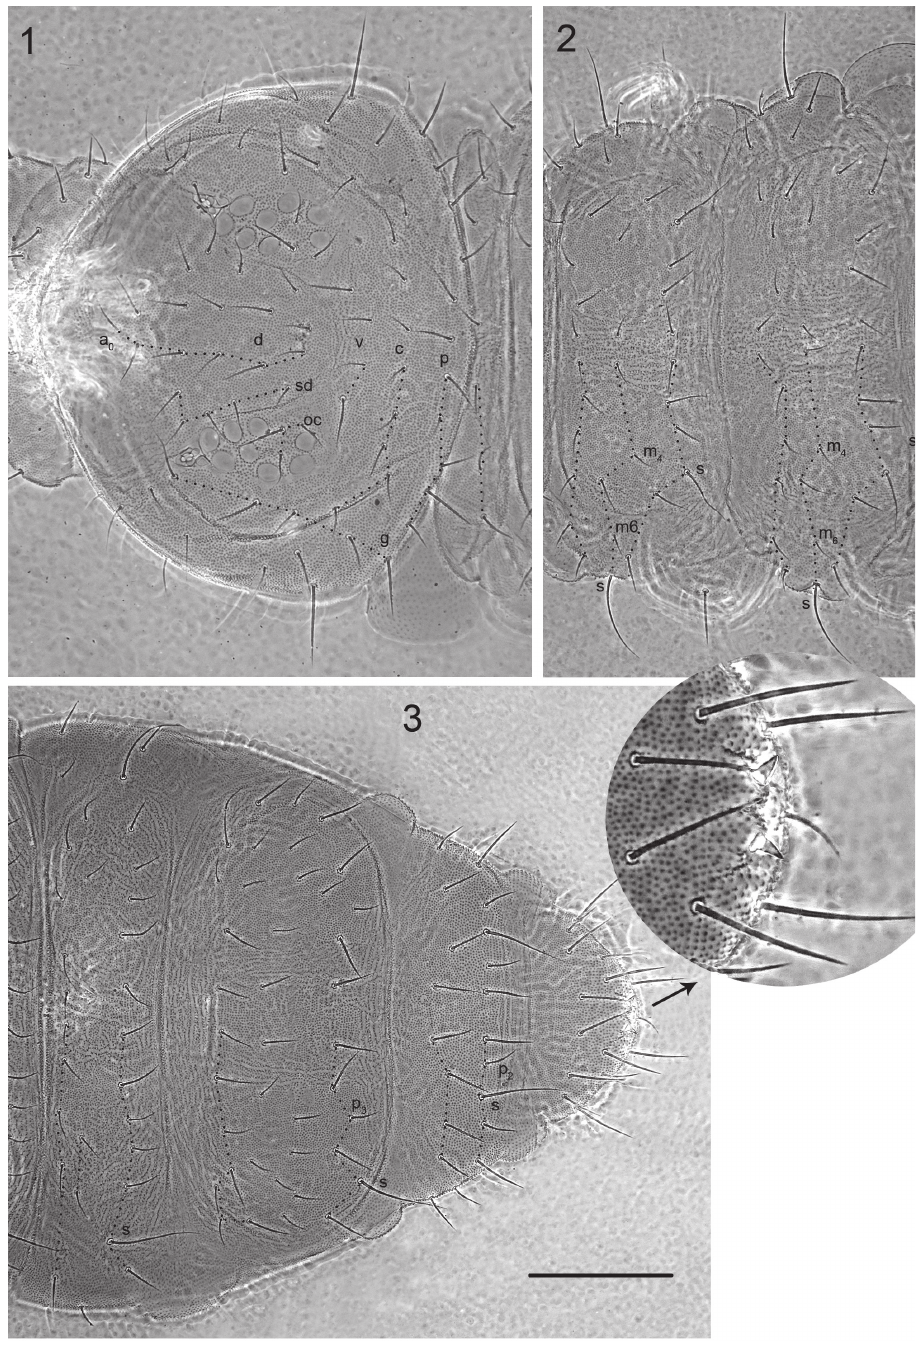
Figures 1–3. Hypogastrura ellisi sp. n. 1 chaetotaxy of head and Th. I 2 chaetotaxy of Th. II–III 3 chae- totaxy of Abd. III–VI. Scale bar: 0.1